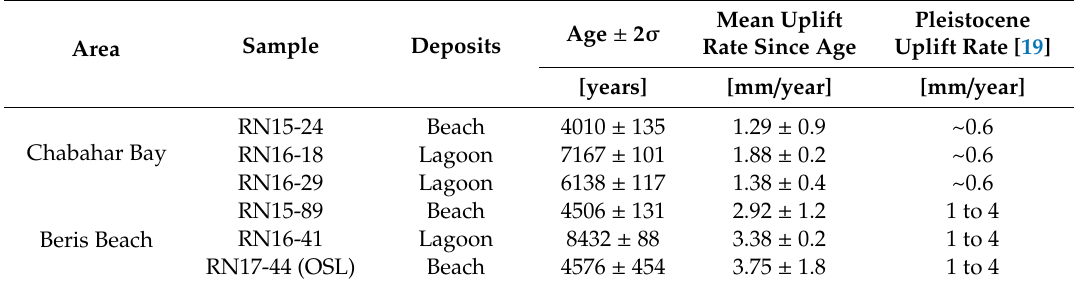
Figure 10. Scenarios of vertical displacements on a seismically active subduction zone. eq: earthquake. ( A ) Vertical deformation distribution based on a viscoelastic model of elastic rebound for a thrust earthquake [81]. Our example scenarios of Figure 10B–D are at ~ − 5H from the trench (dashed black line), where coseismic subsidence and interseismic uplift occurs. Red and green lines represent the interseismic and coseismic movement of the continent (overriding plate of a subduction thrust), respectively. ( B , C ) show two di ff erent scenarios, where the timing of sample deposition and present day position within the seismic cycle a ff ect the resulting short-term uplift rates. Do fast Holocene rates calculated for the Makran imply an upcoming coseismic subsidence earthquake (like in Figure 10C)? ( D ) Example showing how samples with di ff erent ages and having di ff erent uplift rates suggest a non-linear history of vertical displacements. ( E ) Example where continuous deformation happens without coseismic vertical displacements, U1, U2 and U are expected to be equal. Table 4. Holocene uplift rates. Uplift rates based on lagoonal deposits are more precise than those based on beach deposits. More details in Supplementary Text S2 and Table